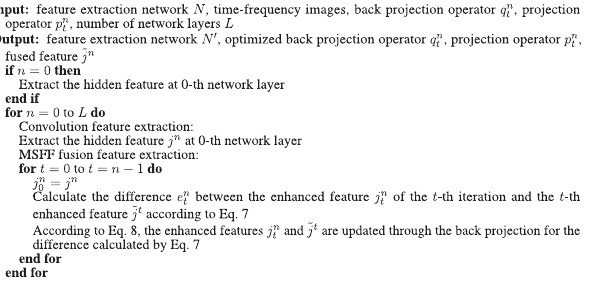
Algorithm 1. Fault feature enhancement algorithm based on multi-scale feature fusion